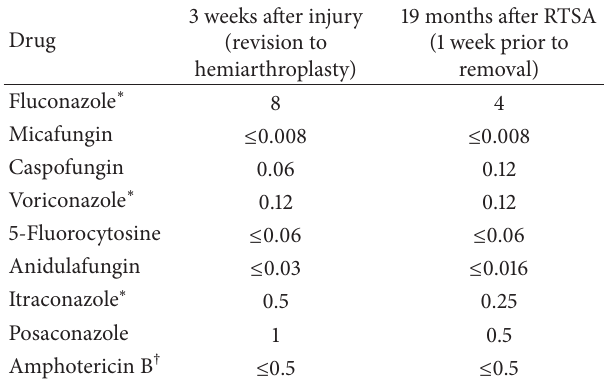
Figure 1: Radiograph of the patient’s shoulder after the initial injury. Table 1: Susceptibility results of our patient’s C. glabrata isolates to various antifungal drugs at the time of revision from the ORIF to the hemiarthroplasty and oneweek priortotheresection arthroplastyof the reverse total shoulder arthroplasty